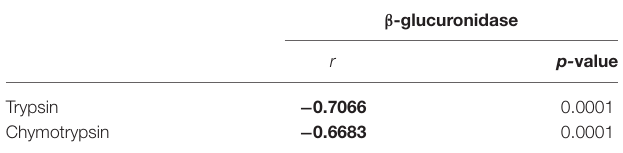
TABLE 1 | Correlation between β -glucuronidase, trypsin and chymotrypsin.